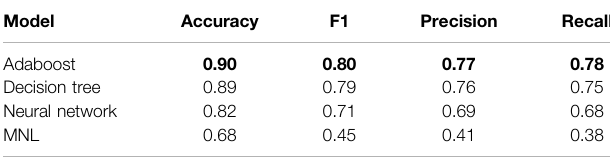
TABLE 4 | Summary of all models classi fi cation performance.